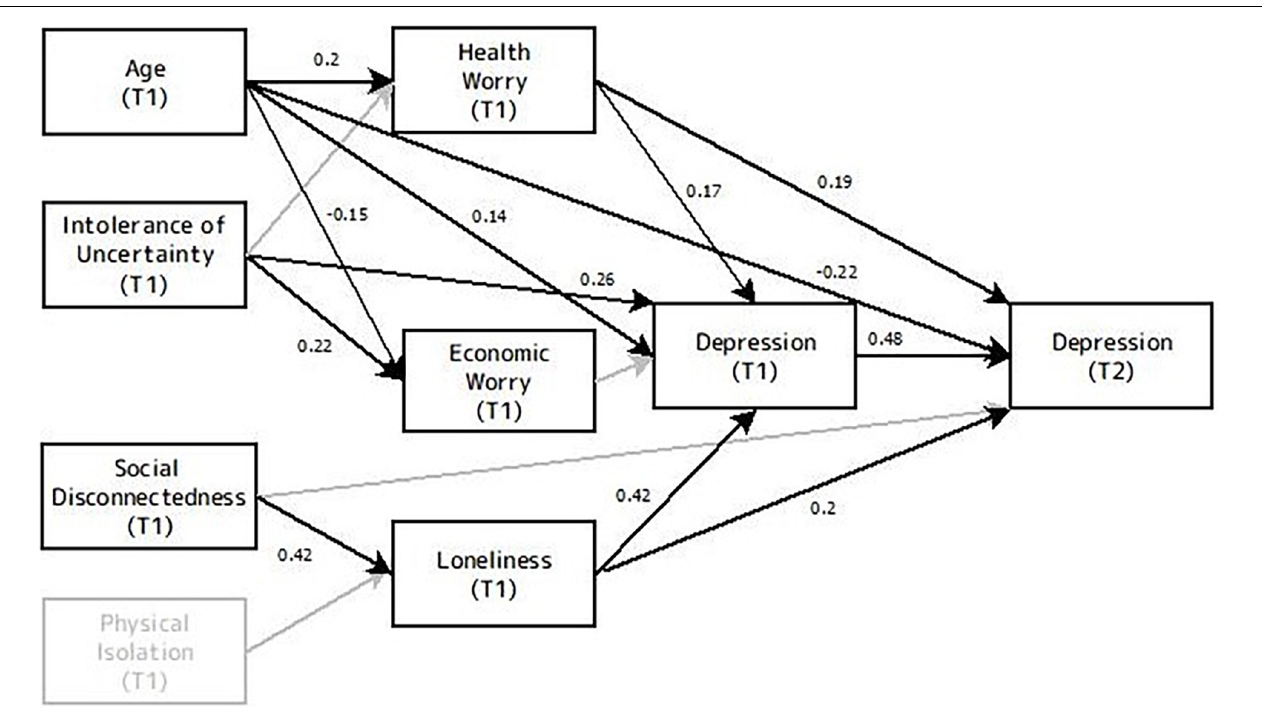
FIGURE 3 | Model of the relationships among age, economic worry, health worry, physical isolation, social disconnectedness, loneliness, intolerance of uncertainty, depression levels from phase 1 and symptoms of depression in phase 2. T1 indicates variables from phase 1, and T2 indicates variables from phase 2. Black lines represent connections in the best fitted model. Gray lines represent non-significant connections that are not included in the final model. Values embedded in unidirectional arrows are standardized regression weights.